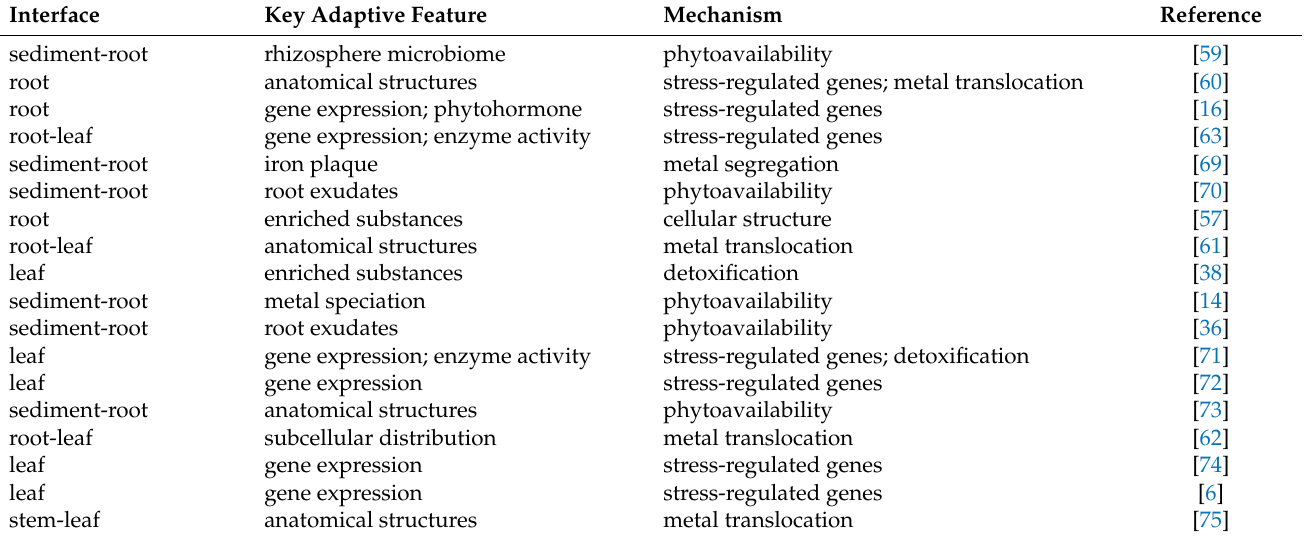
Table 2. Summary of defense strategies of mangroves associated with trace metal tolerance.